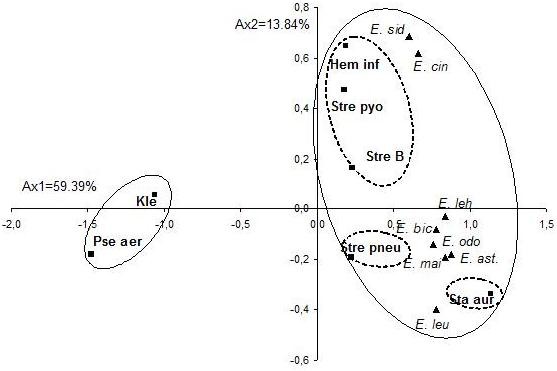
PCA of the antibacterial activity of 08 Eucalyptus essential oils species against seven clinical bacteria (■). For the abbreviation of the Eucalyptus species (▴) see Table 1.■) Hem inf = Haemophylis influenza, kle = Klebsiella pneumoniae = Pse aer: Pseudomans aeruginosa, sta aur = Staphylococcus aureus, Stre B = Streptococcus agalactiae, Stre pneu = Streptococcus pneumoniae, Strep pyo = Streptococcus pyogenes.